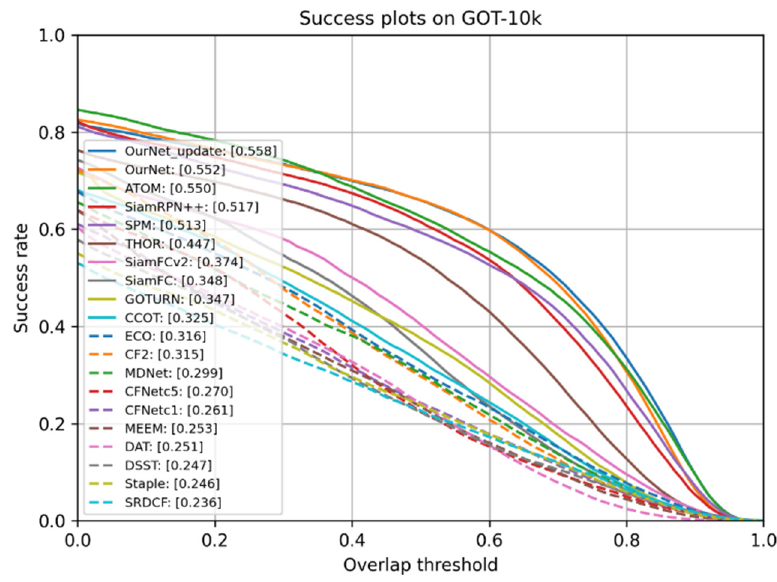
Figure 9. Comparison results of the GOT-10k benchmark.